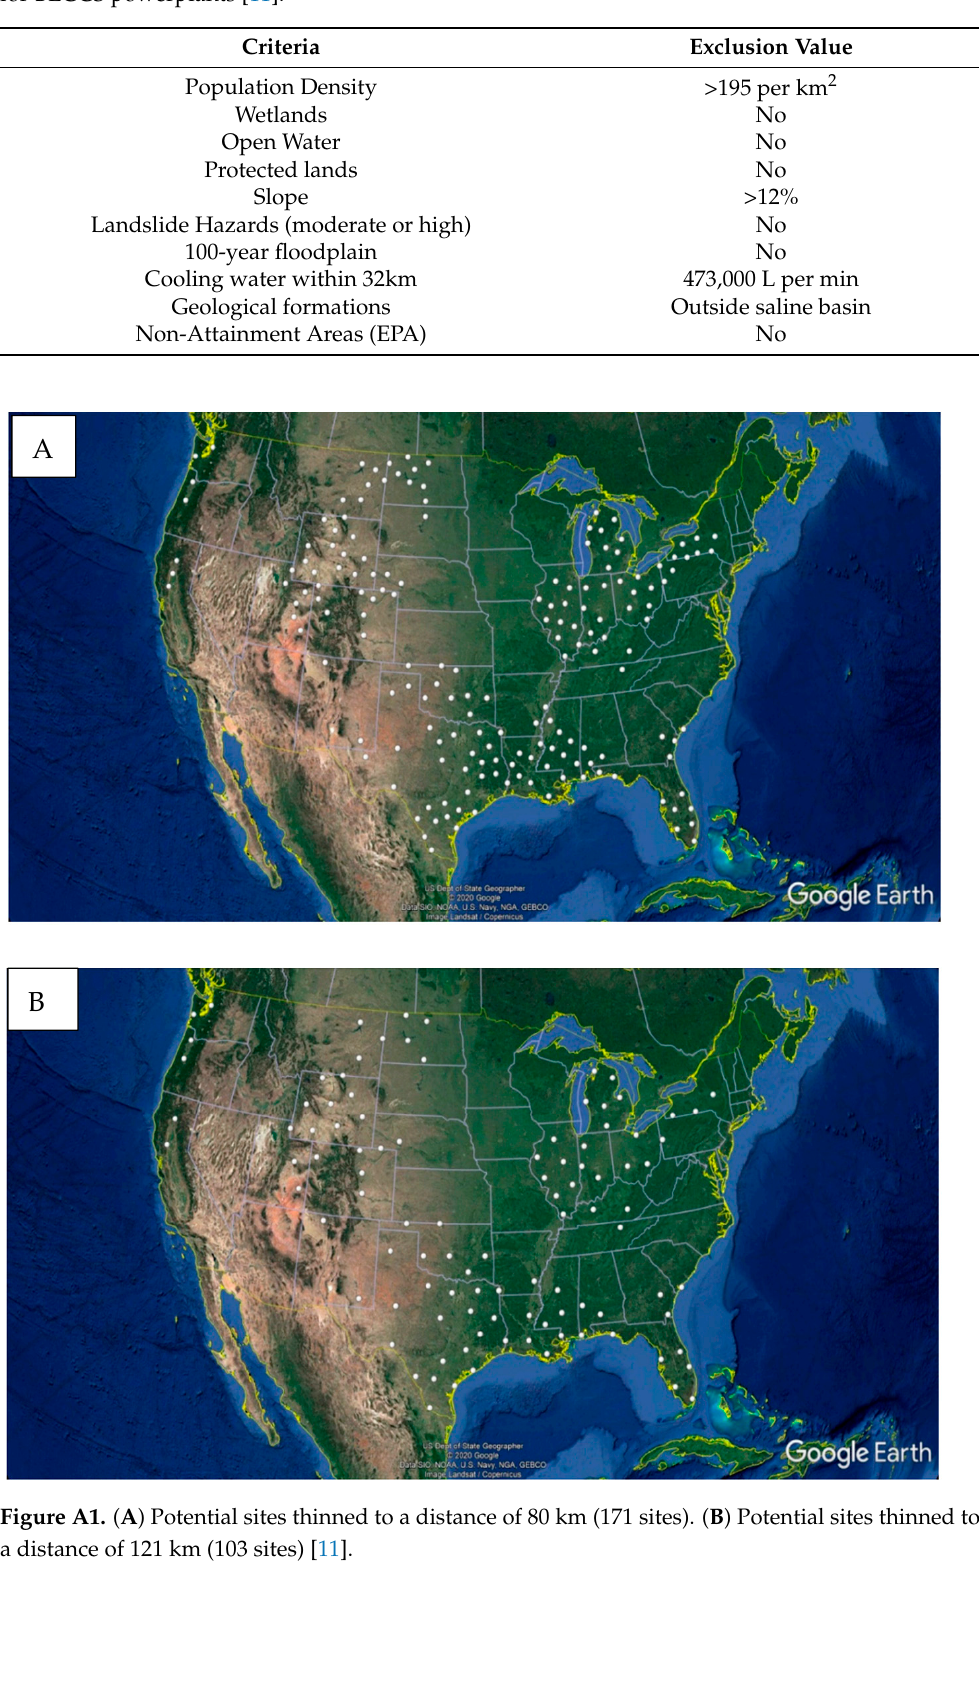
Table A9. Exclusionary parameters and their values used in OR-SAGE to determine potential sites for BECCS powerplants [11].